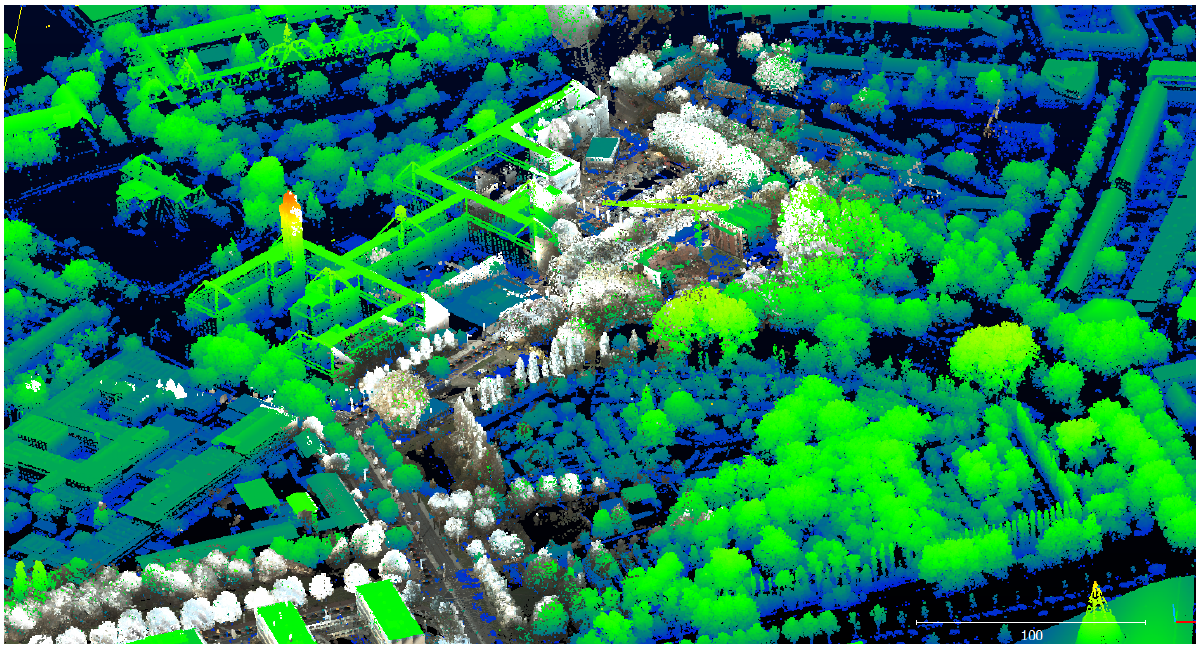
Figure 6: The original AHN2 point cloud (the larger cloud) and MLS point cloud (containing the color information for each point) are shown together.